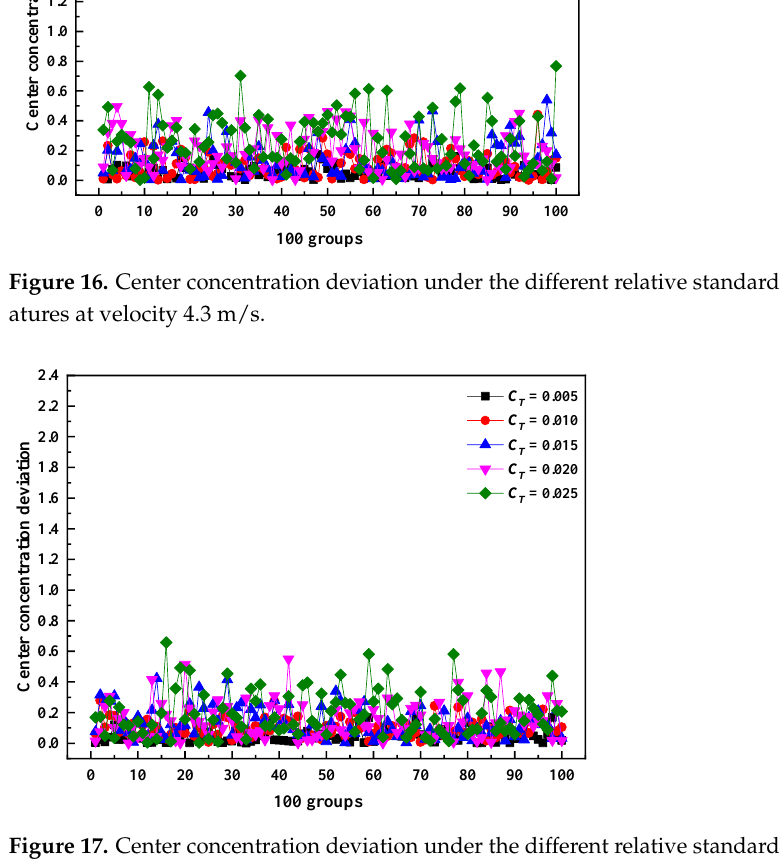
Figure 18. Relationship between different inlet velocity and the mean of center concentration de- viation under different relative standard deviations of temperature. It can be seen from Figures 13 – 17 that the catalyst inlet velocity has a significant ef- fect on the center concentration deviation under different relative standard deviations of temperature. When the inlet velocity is large under the same relative standard deviation of temperature, the center concentration deviation fluctuates less. Figure 18 shows that when the relative standard deviation of temperature is constant, with increasing inlet velocity, the mean of center concentration deviation rises at first and then declines, reaching a maximum when the inlet velocity is 2.1 m/s. It can be explained that when the inlet velocity is 2.1 m/s, the denitration efficiency is most obviously affected by the tem- perature change. Therefore, the difference in NO removal effect at different tempera- tures and positions is more significant, and the center concentration deviation becomes larger. In addition, it can be seen from Figure 18 that the smaller the relative standard deviation of temperature, the smaller the influence of the inlet velocity on the mean of the center concentration deviation. When the relative standard deviation of temperature is reduced to 0.005, the mean of the center concentration deviation of the five inlet veloc- ities is close. Figures 19 – 23 show the relationship between deviation grade standard and confi- dence of measurement results under cases 1 ~ 5, 6 ~ 10, 11 ~ 15, 16 ~ 20, and 21 ~ 25, re- spectively. Figure 24 shows the relationship between different velocities and the confi- dence of measurement results under the different relative standard deviations of tem- perature when the deviation grade standard is 0.25.